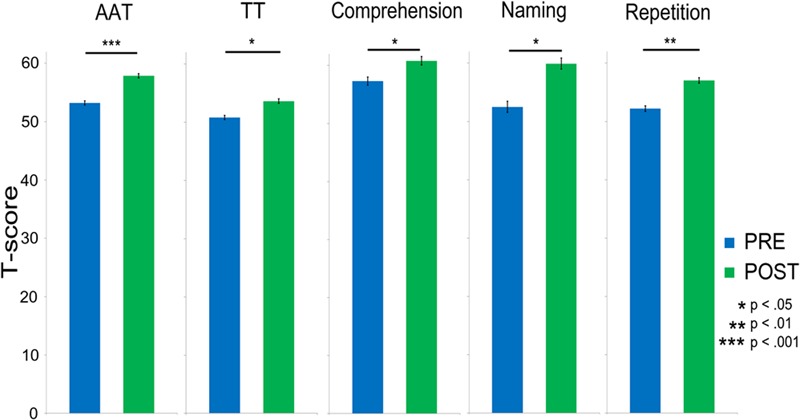
Bar charts showing the significant improvements in language abilities after treatment as assessed by the Aachen Aphasia Test (AAT) overall mean score and by all its four sections: Token Test (TT), Comprehension, Naming, and Repetition. Asterisks indicate statistical significance levels after Bonferroni–Holm’s procedure (∗p < 0.05; ∗∗p < 0.01; ∗∗∗p < 0.001). Error bars show standard errors.